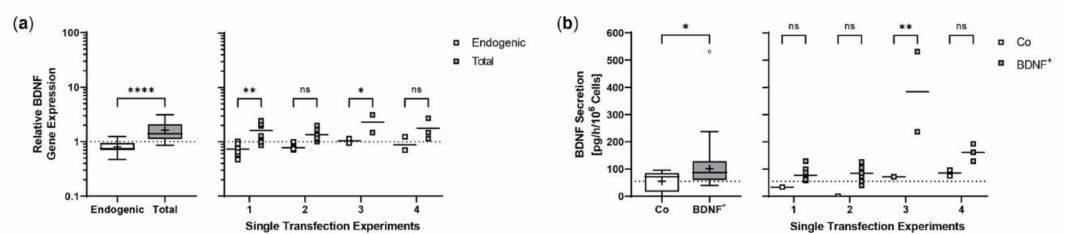
Figure 8. Transposition efficiency in primary hRPE cells transfected with a defined ratio of SB100X transposase to BDNF transposon plasmid. In each experiment ( n = 4), two to eight transfections were performed using 5 × 10 4 or 1 × 10 5 cells from individual donors (donor age: 66.5 ± 9.95 years, gender: four males, time postmortem: 29.8 ± 28.0 h, cultivation time before transfection: 74.8 ± 51.1 days) and a mixture of 0.03 µ g SB100X transposase and 0.47 µ g BDNF transposon plasmid (BDNF + ), plus one or two controls without the addition of plasmid DNA (Co). Cultures were terminated 22 days after transfection. Cells were used for isolation of total RNA. Medium used for ELISA was added to the cells in a defined volume 24 h before culture termination. ( a ) BDNF gene expression was analyzed by qPCR. Endogenous and total BDNF expression in BDNF + cultures were related to the respective expression in Co cultures, which were set to 1 (dashed line). An increase in total BDNF expression was observed in the BDNF + cultures (ns: not significant, summarized data: **** p < 0.0001, unpaired t test with Welch’s correction; single experiments: * p = 0.0418, ** p = 0.0023, 2way ANOVA with